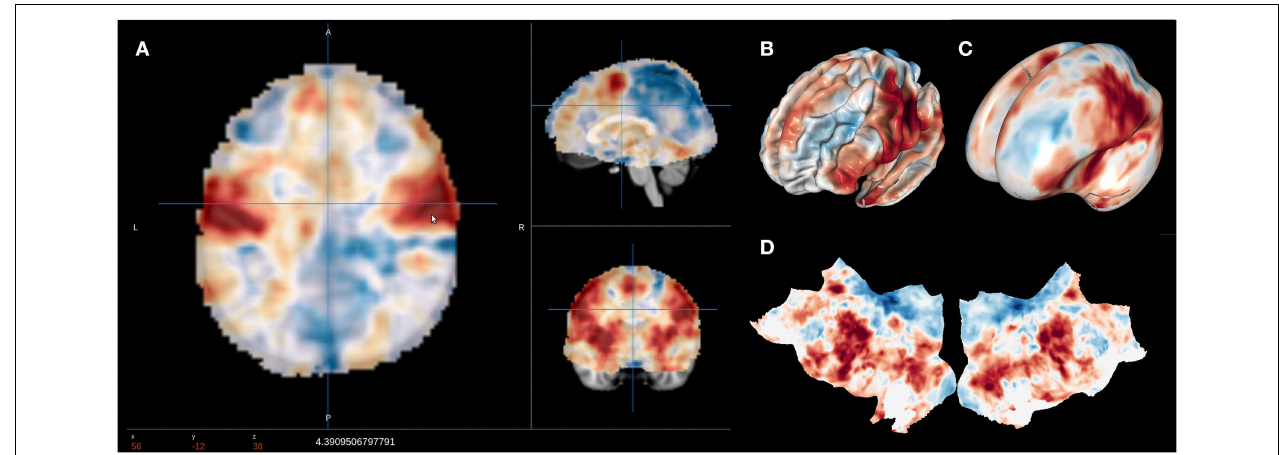
FIGURE 2 | Visualization options available in NeuroVault. The user can choose to interactively interrogate the images using 2D volumetric view (A) , 3D fiducial view (B) , 3D inflated view (C) , or a flattened cortical surface map (D)